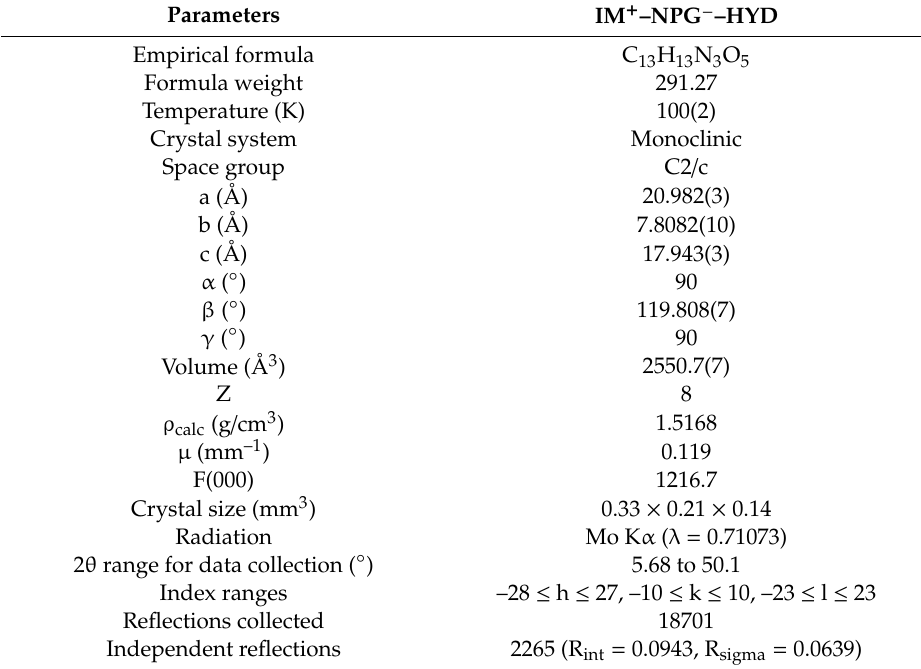
Table 6. Structure-refinement and crystal data for complex IM + –NPG — HYD